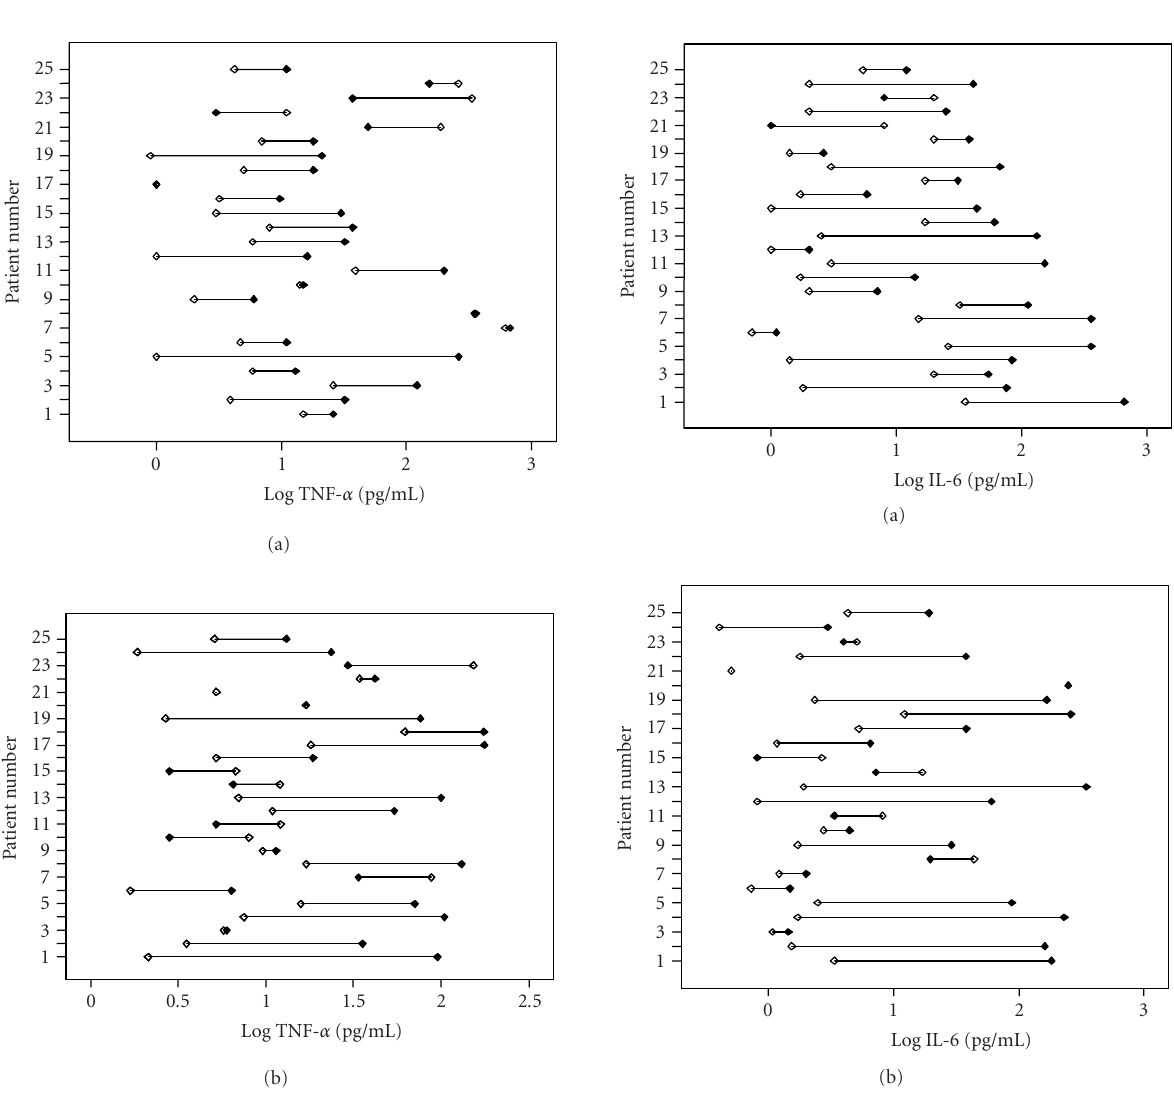
Figure 2. Individually plotted values of IL-6 (logarithmic scale) in involved (closed symbols) and uninvolved sides (open sym- bols) of all CRPS 1 patients, (a) at first measurement (T0) and (b) at follow-up measurement (Tf). Note that on T0 (acute stage), 23 patients displayed an increased value in the involved versus the uninvolved extremity, whereas on Tf (intermediate stage), still 18 patients displayed an increased